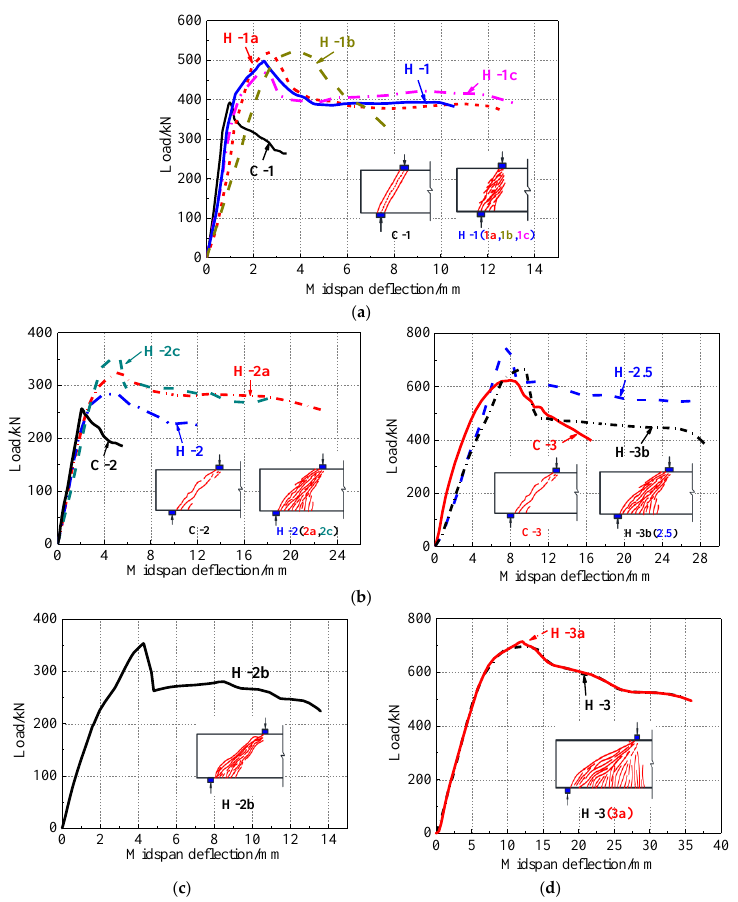
Figure 4. Load – deflection curves. ( a ) Diagonal compression failure, ( b ) shear compression failure, ( c ) diagonal tension failure, ( d ) flexural shear failure.